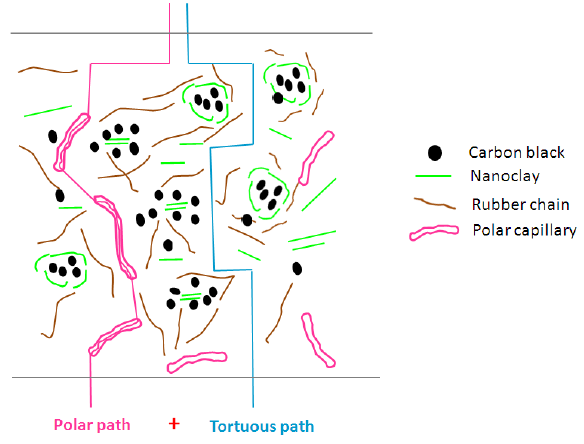
Figure 1: XRD reveals complete exfoliation of the nanoclay in the rubber nanocomposites.